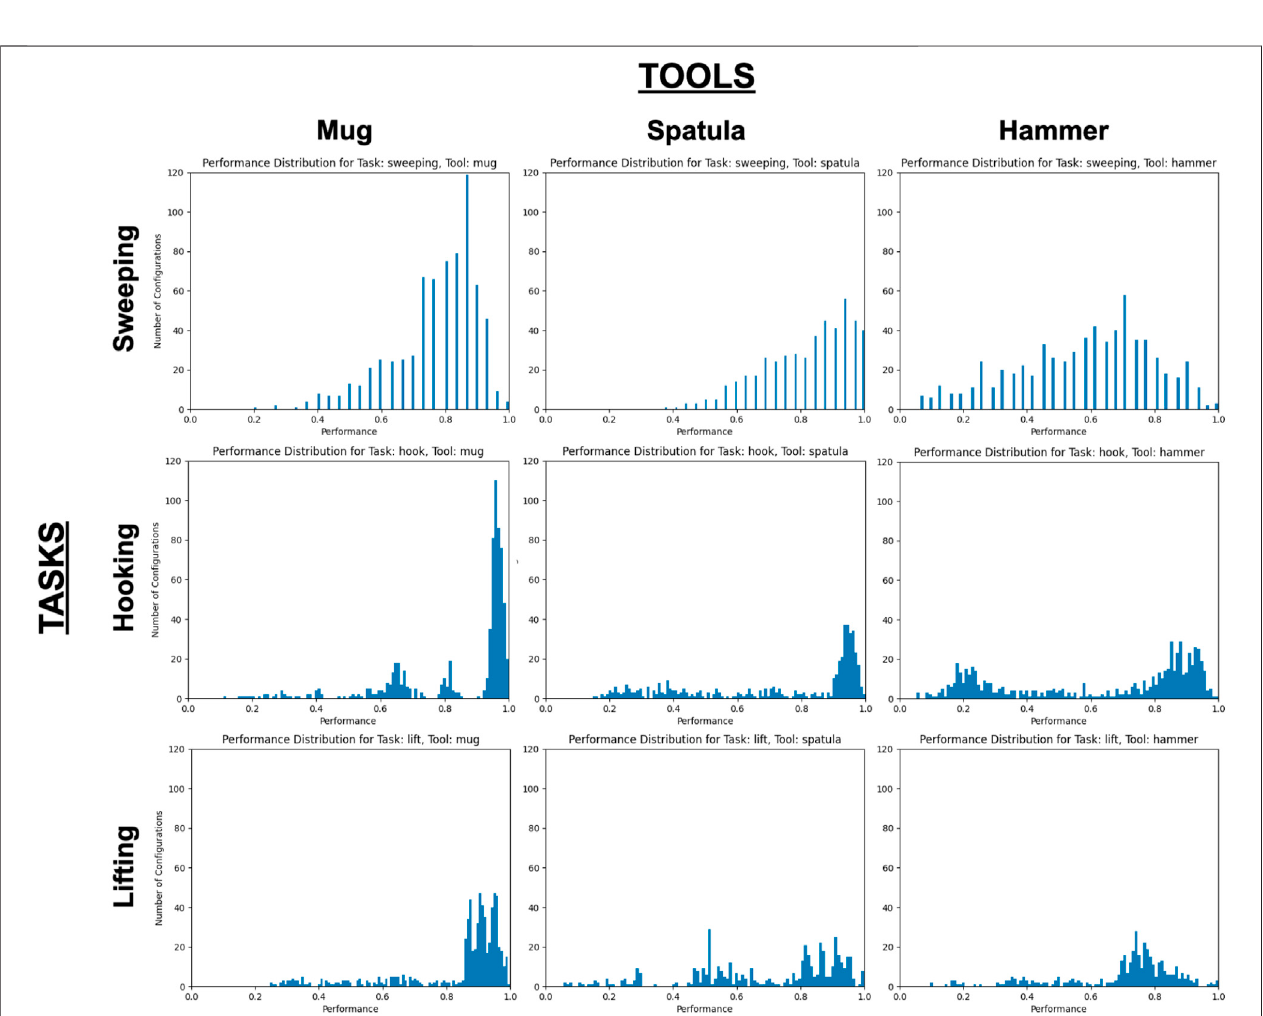
Frontiers in Robotics and AI |